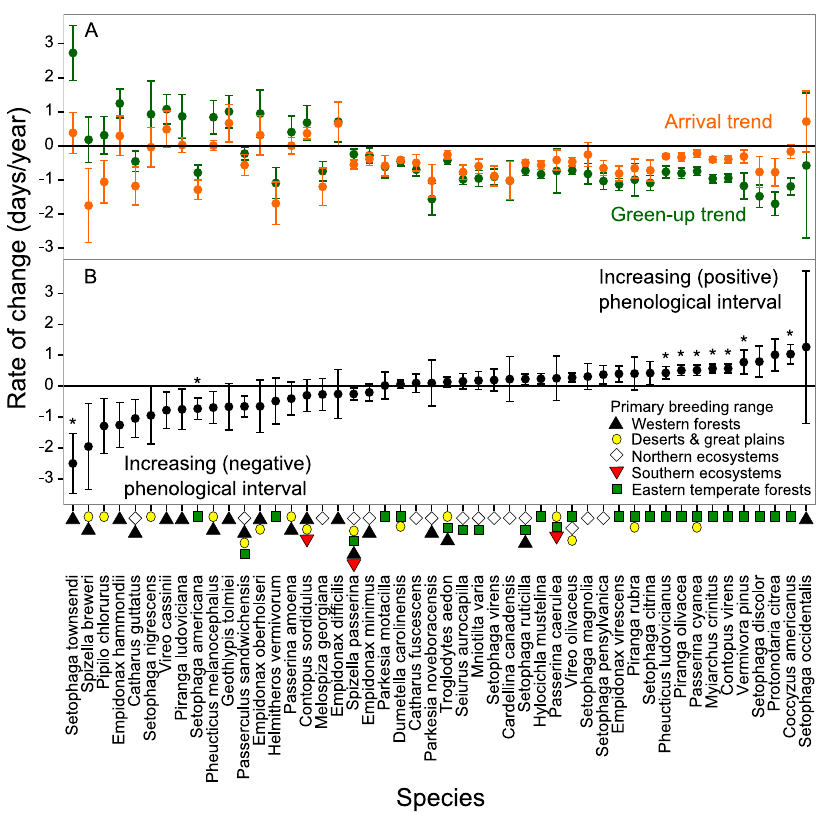
Figure 1. Trends in green-up date, bird arrival date, and phenological interval by species. Bars indicate + / − 1 standard error. Species are ranked by trend in phenological interval. In ( A ), positive values indicate arrival (orange) or green-up (green) are getting later, negative values indicate they are getting earlier. Note that for species on the right (with increasing phenological interval), green-up is getting earlier at a greater rate than is arrival. In ( B ), positive values indicate increasing phenological interval (black) between green-up and arrival date. Coloured symbols below the panel indicate the general location(s) of the species’ breeding range in North America. Asterisks indicate statistically significant trends in phenological interval (p < 0.05). Note that species on the right (with increasing positive phenological interval) tend to breed in Eastern Temperate Forests, whereas species on the left (with increasing negative phenological interval) tend to breed in Western